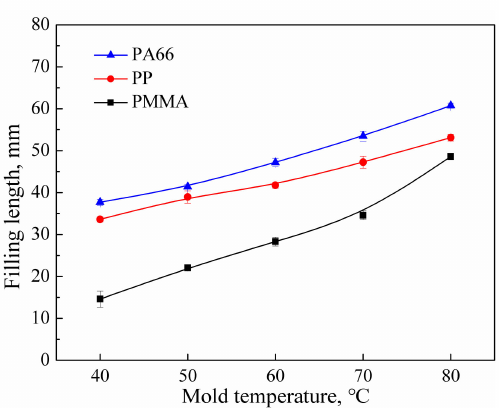
Figure 6. Effect of mold temperature on the filling length of polymer melt (UA = 40 µ m, PPe = 14 MPa, UT = 6 s, HT = 6 s, HP = 14 MPa; Mold